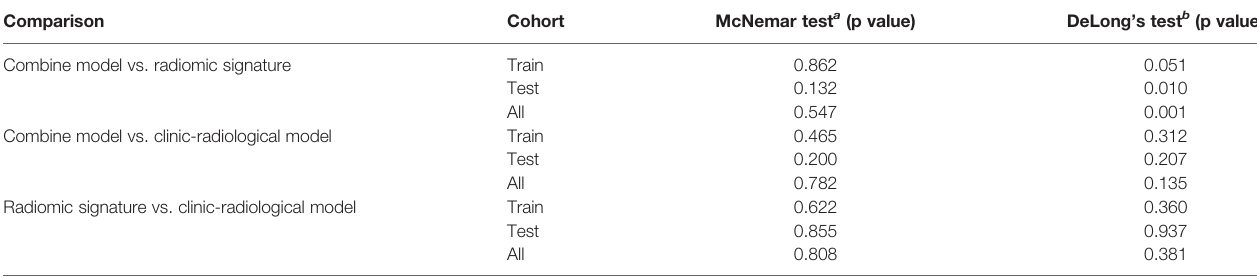
TABLE 4 | Comparison of the performance of models in the testing